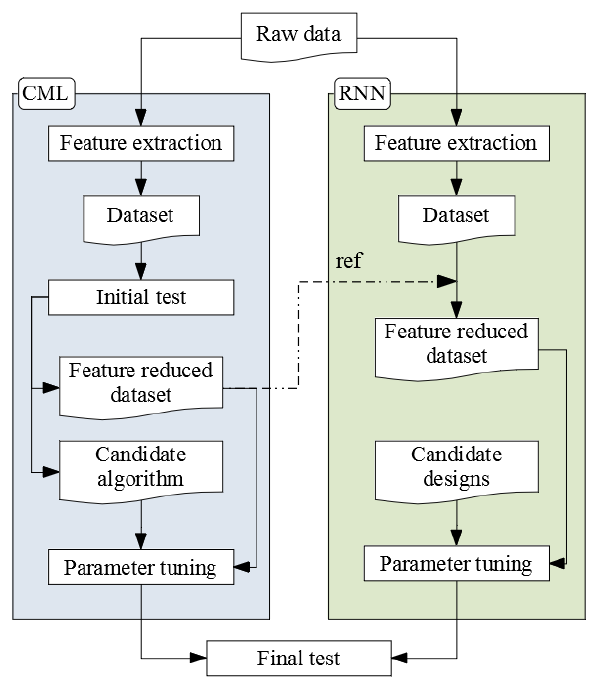
Figure 6. Data handling